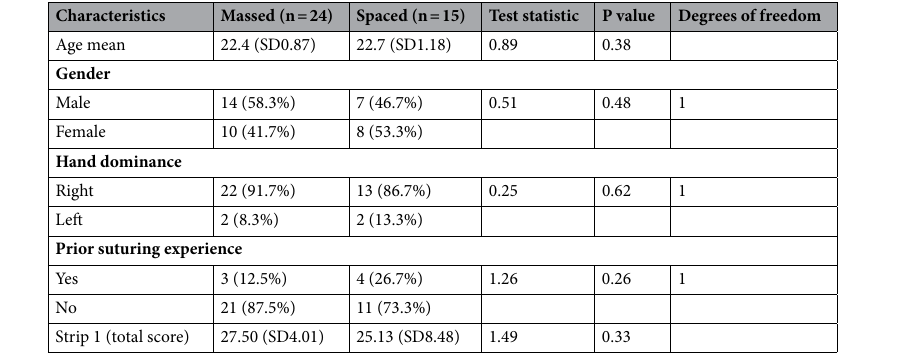
Table 1. Baseline characteristics of